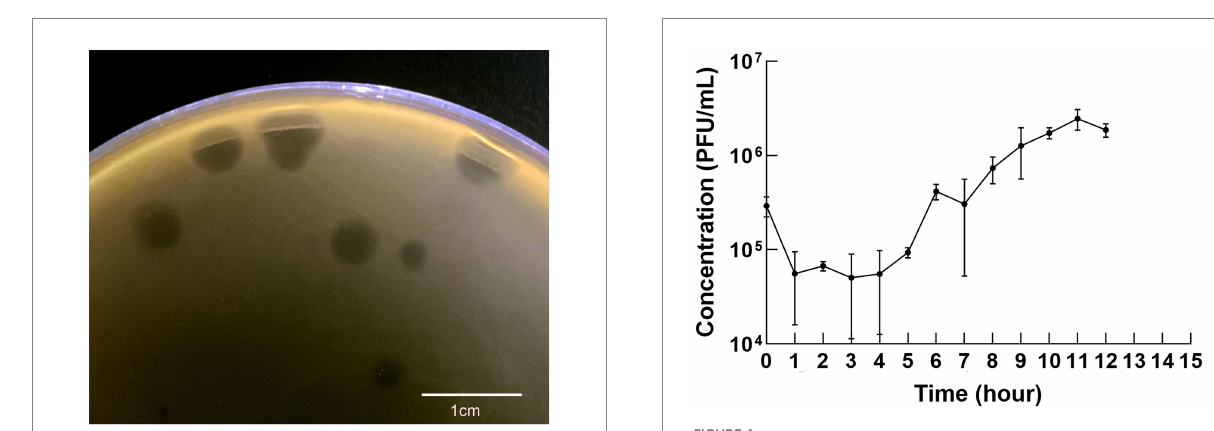
FIGURE 4 One-step growth curve. The incubation period was 5 h, and the burst size was 26 PFU/cell.